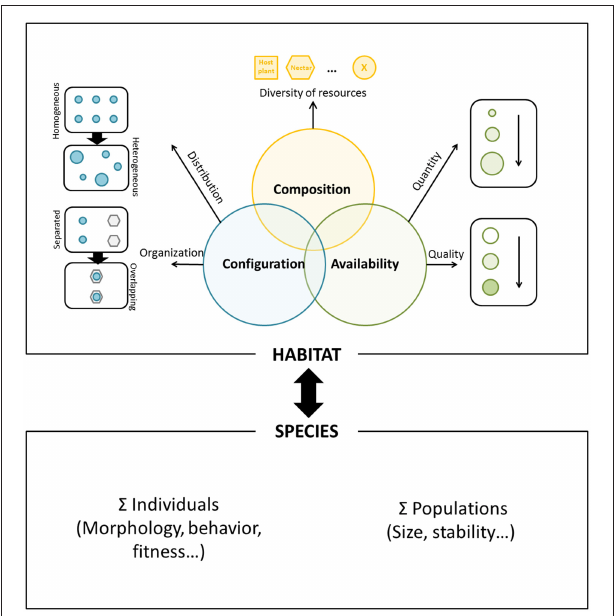
FIGURE 1 | Schematic representation of the resource-based habitat concept. Resource composition (upper part of the figure) refers to the diversity of ecological resources used by the focal species, such as at least host plant and nectar resources for a butterfly species. Resource configuration (left part) refers to the distribution of each ecological resource (i.e., resource grain, from a homogeneous to a heterogeneous distribution of a single resource) and spatial organization (i.e., from fully separated to fully overlapping resources). Resource availability (right part) refers to variation in resource quantity and quality. The intersection of these three components represents the functional habitat of the focal species. Variation in each of these components is likely to affect individual behavior and fitness, in turn affecting both the demographic response of the local population and the underlying evolutionary strategies of resource exploitation and habitat